Question: Write a descriptive caption for this figure.
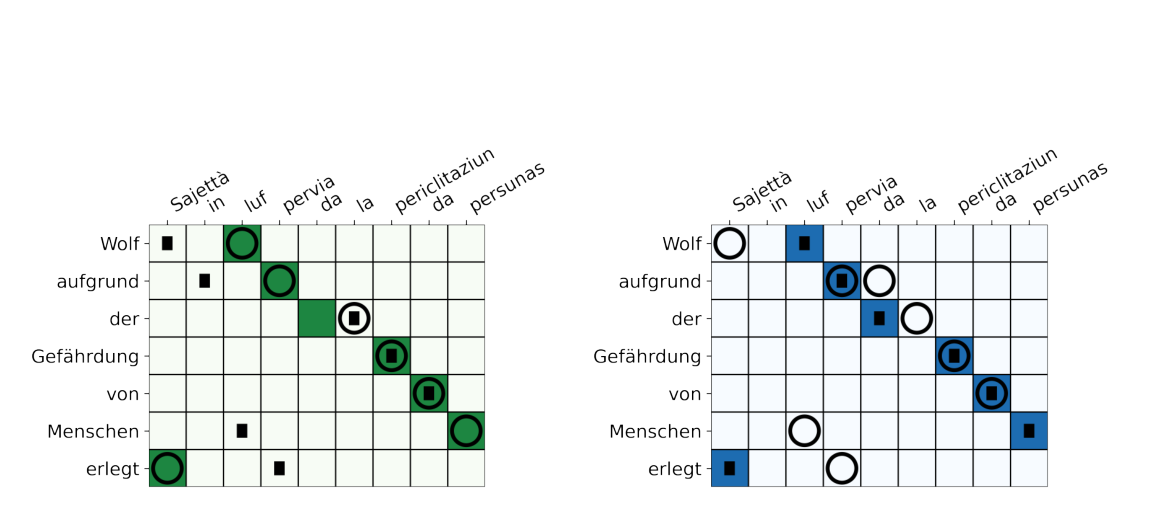
Answer: Example for the clear improvement after fine-tuning. Green: eflomal (boxes) vs. SimAlign (circles); Blue: awesome-align (circles) vs. after fine-tuning (boxes). The dark green/blue squares represent the gold alignments.